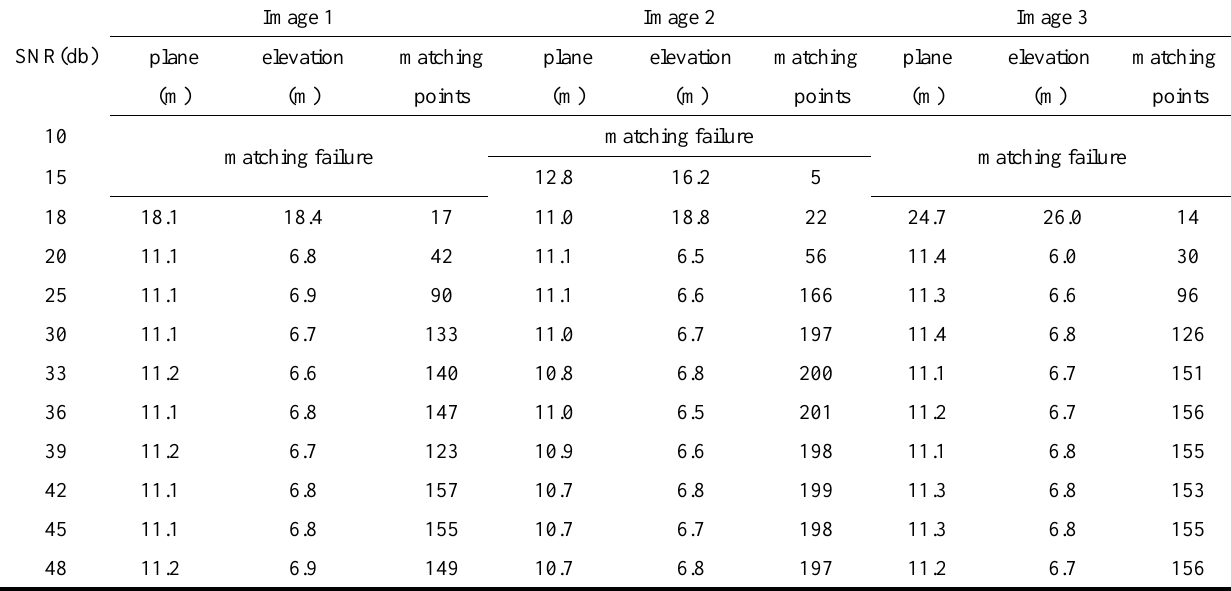
Table 2. the plane error, elevation error and number of matching points with different SNR